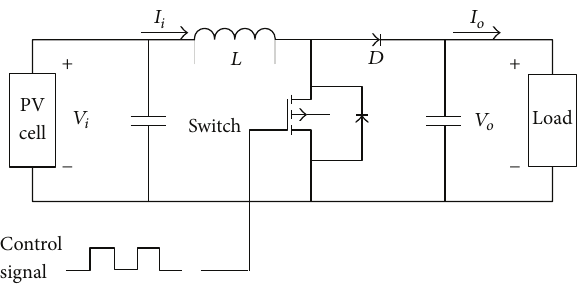
Figure 3: Boost-converter equivalent circuit diagram.